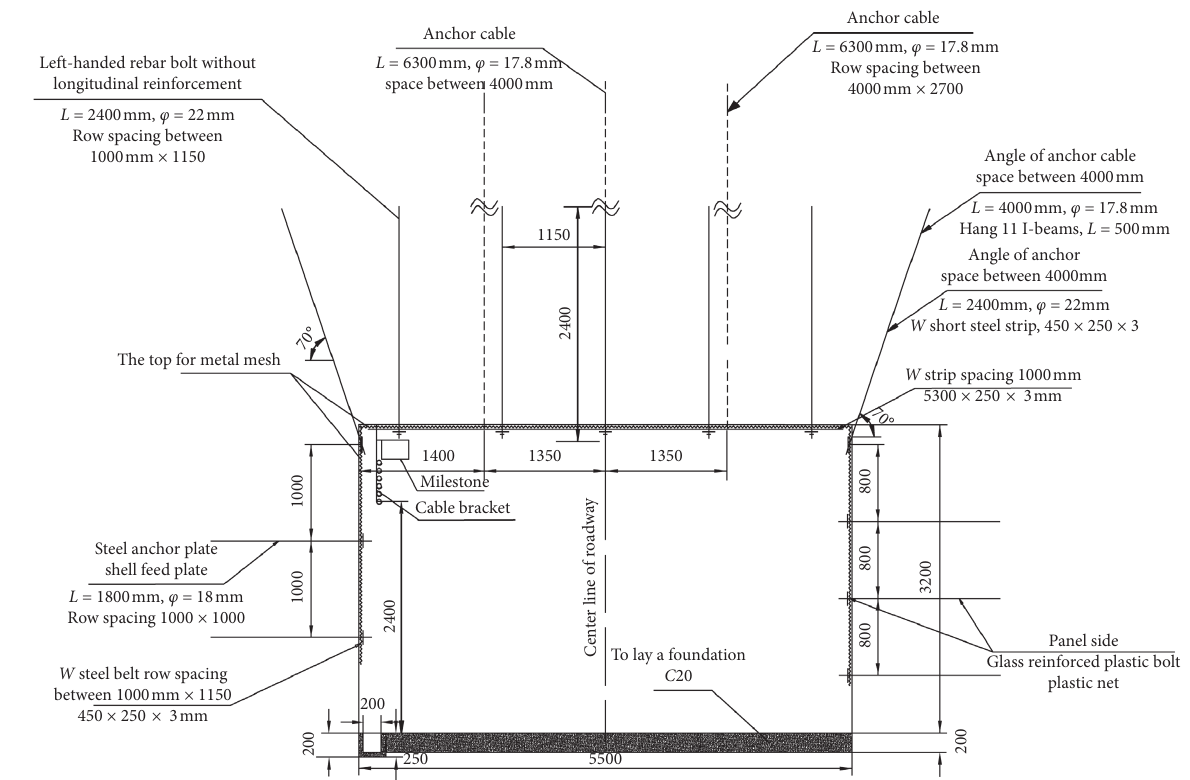
Figure 1: Original support scheme of air-return roadway